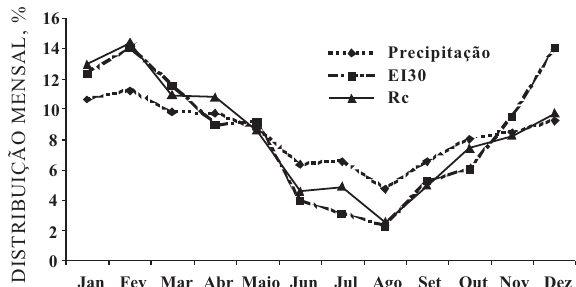
e coeficiente de 30